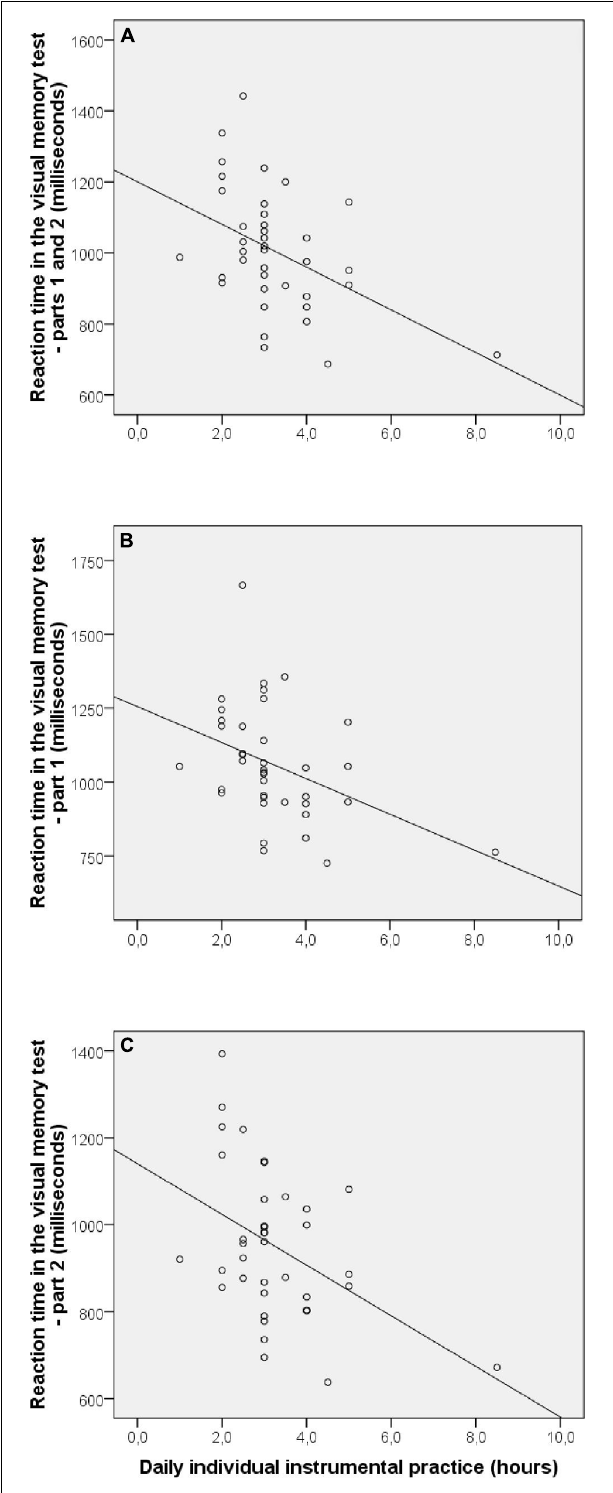
FIGURE 4 | Significant correlations ( p < 0.05) between daily individual instrumental practice and reaction time in the visual memory test – parts 1 and 2 (A), part 1 (B), and part 2